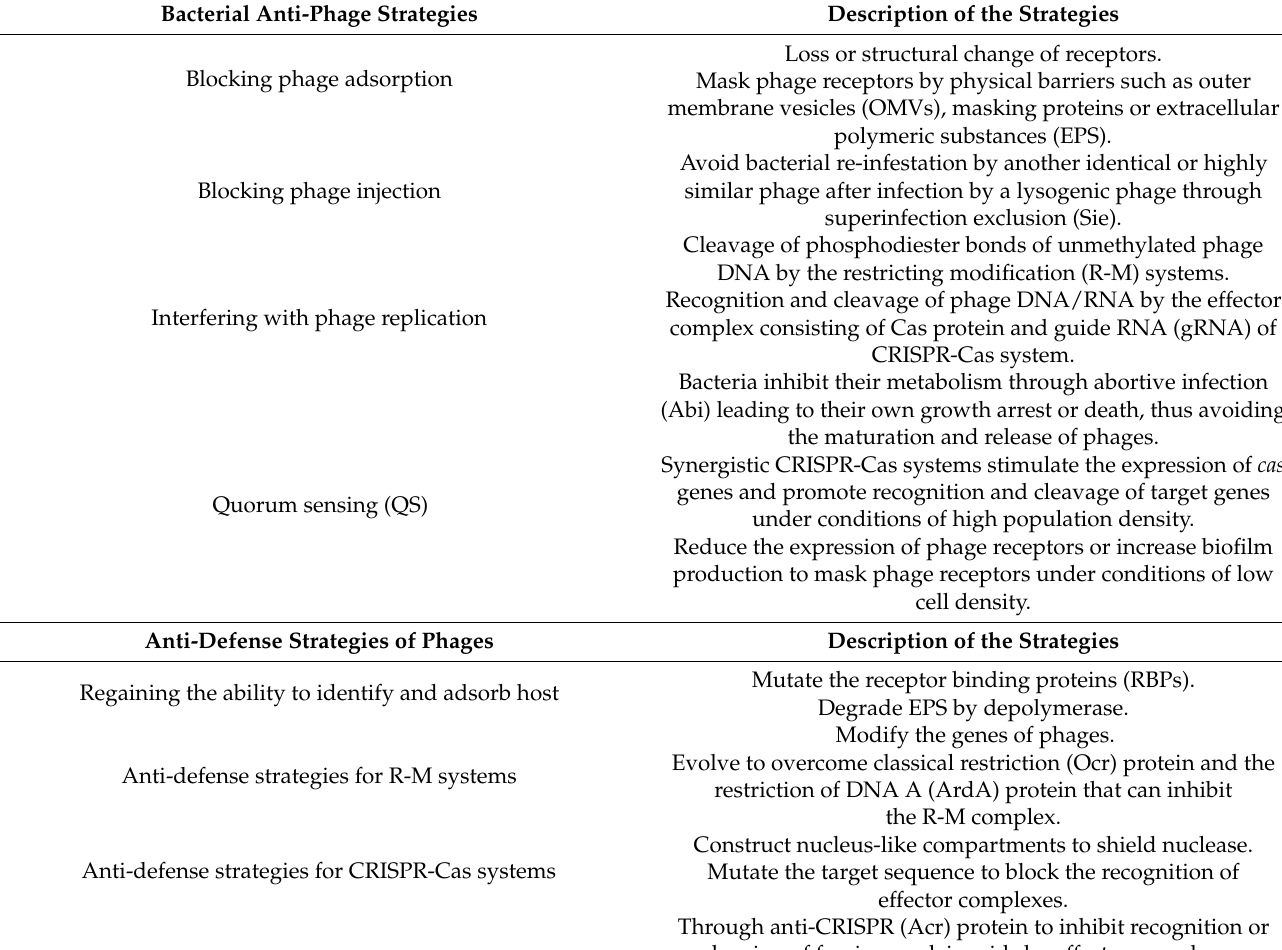
Table 1. Defense and anti-defense strategies between bacteria and